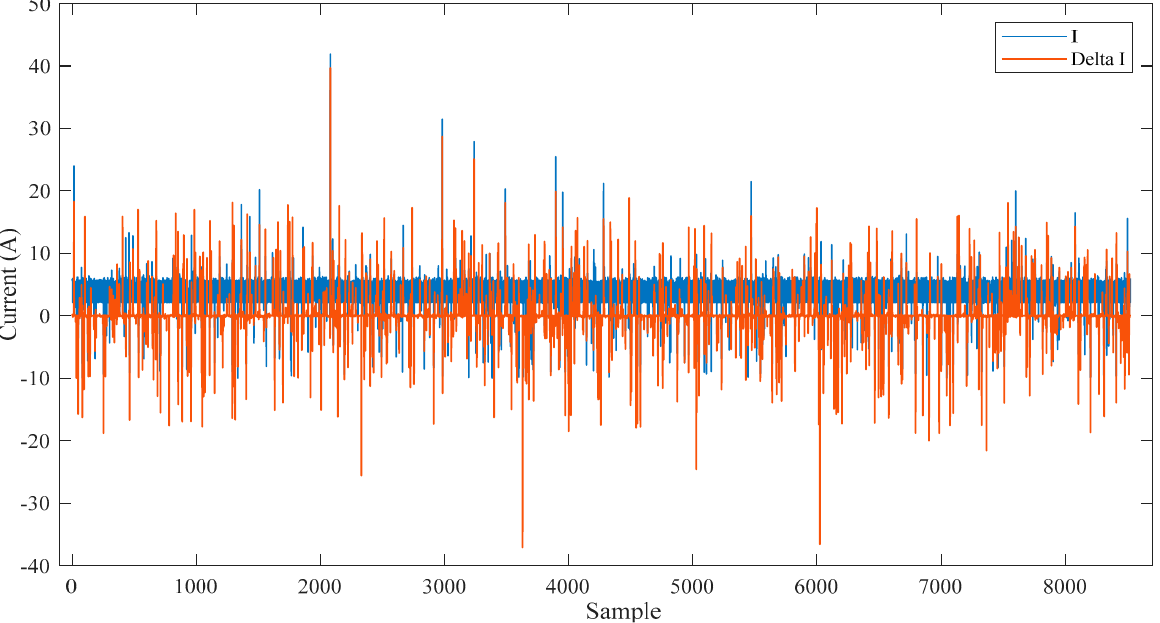
Figure 3. The input training data of the decision tree.